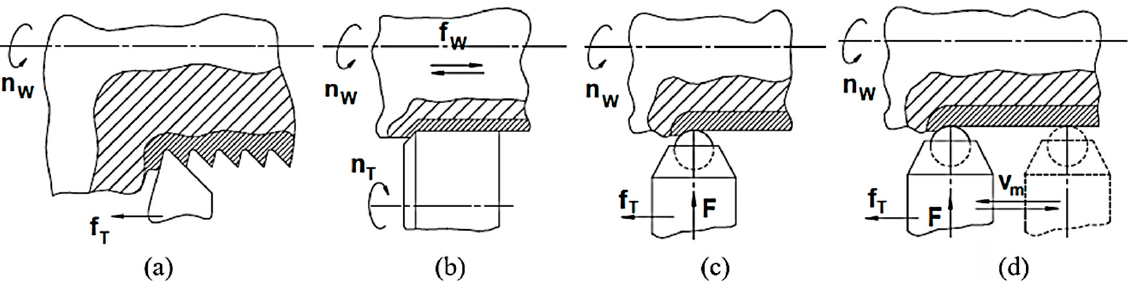
Figure 1. Microchanges in the surface layers after applying various processing methods: ( a ) after turning; ( b ) after grinding; ( c ) after burnishing; ( d ) after vibroburnishing.